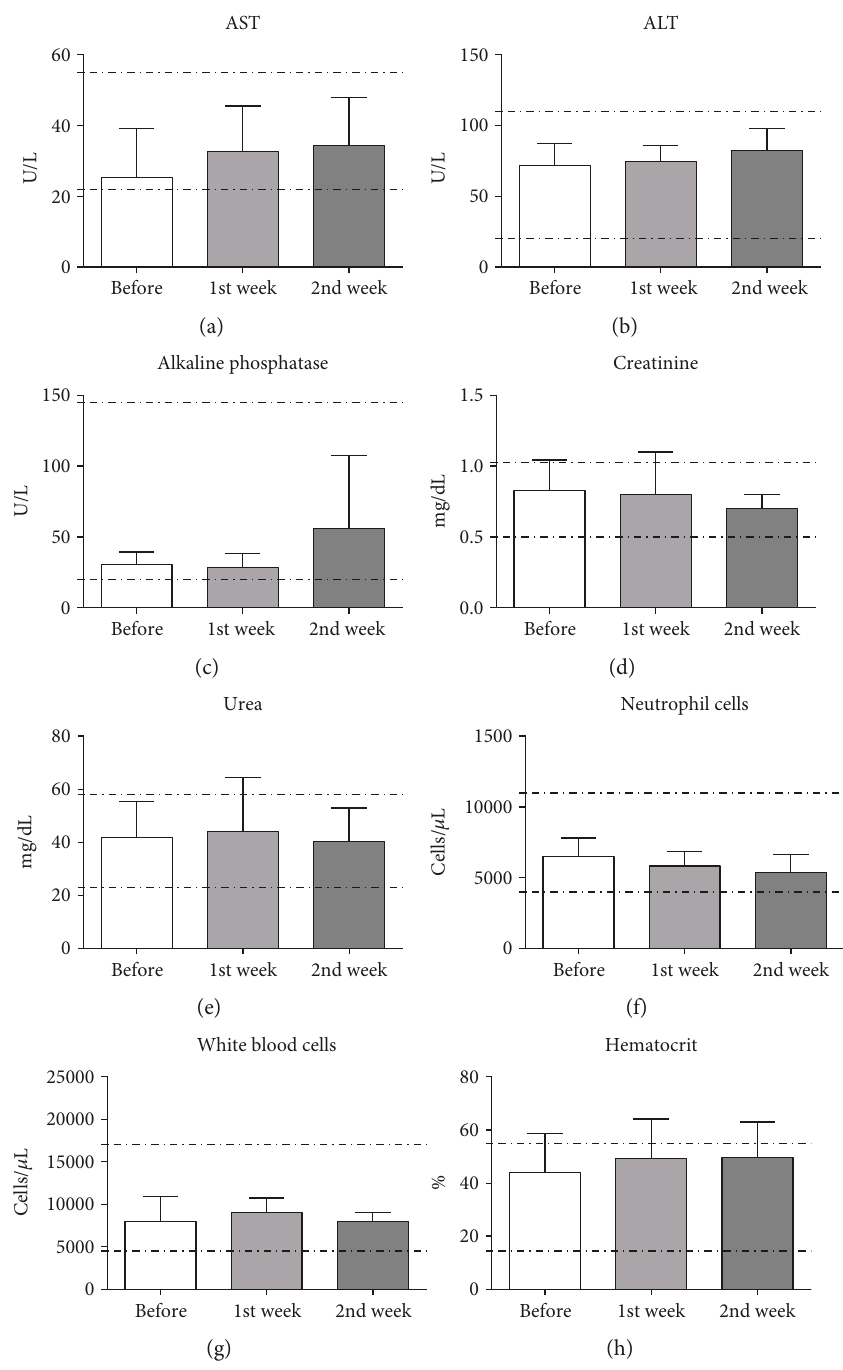
Figure 5: Evaluation of biochemical and hematological markers. AST (a), ALT (b), ALP (c) (U/L), creatinine (d), and urea (e) (mg/dL) levels before and one and two weeks after AT-MSC transplantation. Complete blood count (CBC) of animals treated with AT-MSCs: neutrophils (f), total white blood cells (g), and hematocrit (h). Dotted lines show the normal range of values (reference values). No signi fi cant di ff erences were found in serum and blood parameters across time (Student ’ s t -test, p = ns